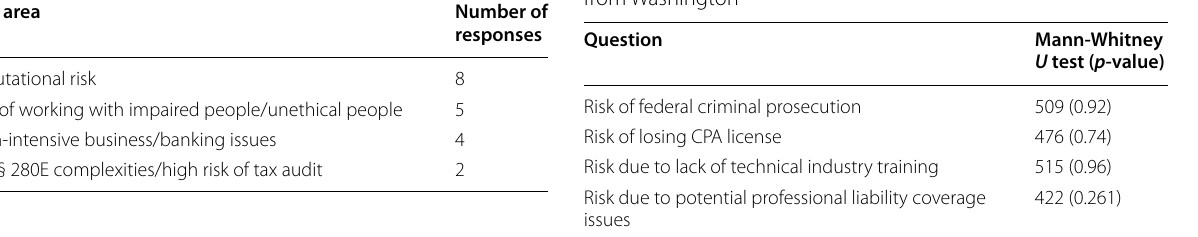
Table 6 Industry risks identified by CPAs from Colorado vs CPAs from